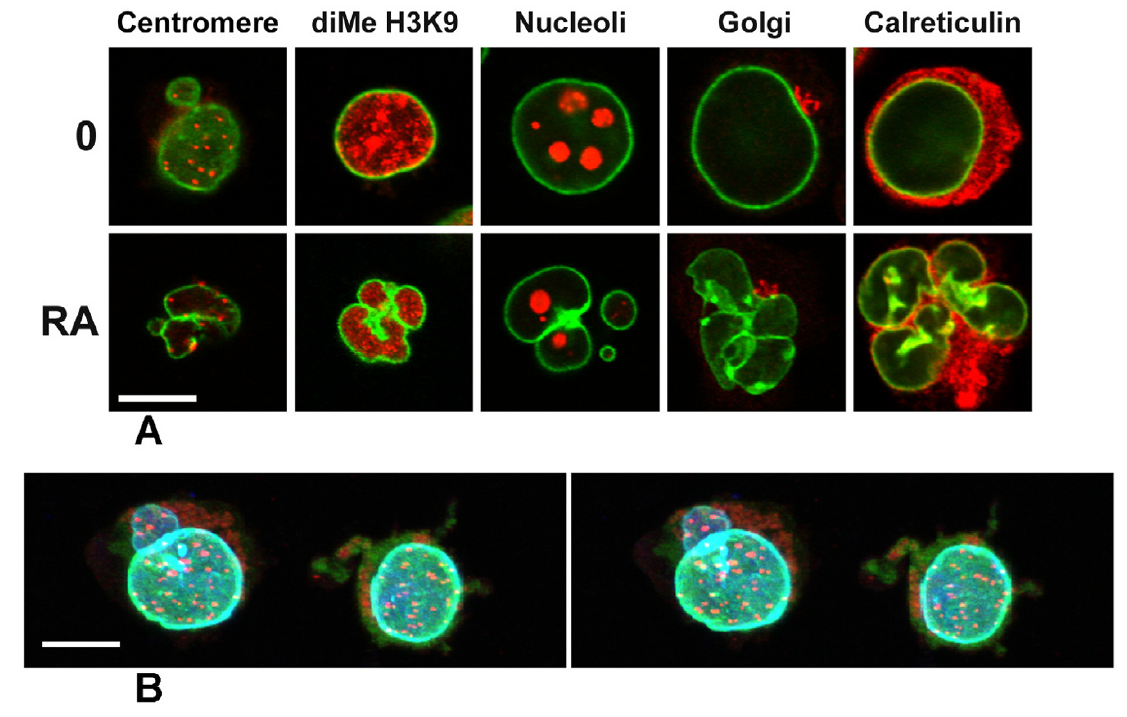
Figure 7 Confocal immunofluorescent images of HL-60- bcl -2 cells. A. Gallery of undifferentiated and RA treated (7 days) cells. The columns (left to right) are: anti-centromere (CREST); anti-dimethyl H3K9; anti-nucleolus; anti-Golgi p58; anti-calreticulin. LMNB is always shown in green; the different antigens in red. Scale bar: 10 µ m. B. Stereo image of undifferentiated HL-60- bcl -2 cells stained with anti-centromere (red), anti-LMNB (blue) and anti-LBR (green). Note the presence of centromeres within a micronucleus, which exhibits a deficiency of LBR. Scale bar: 10 µ